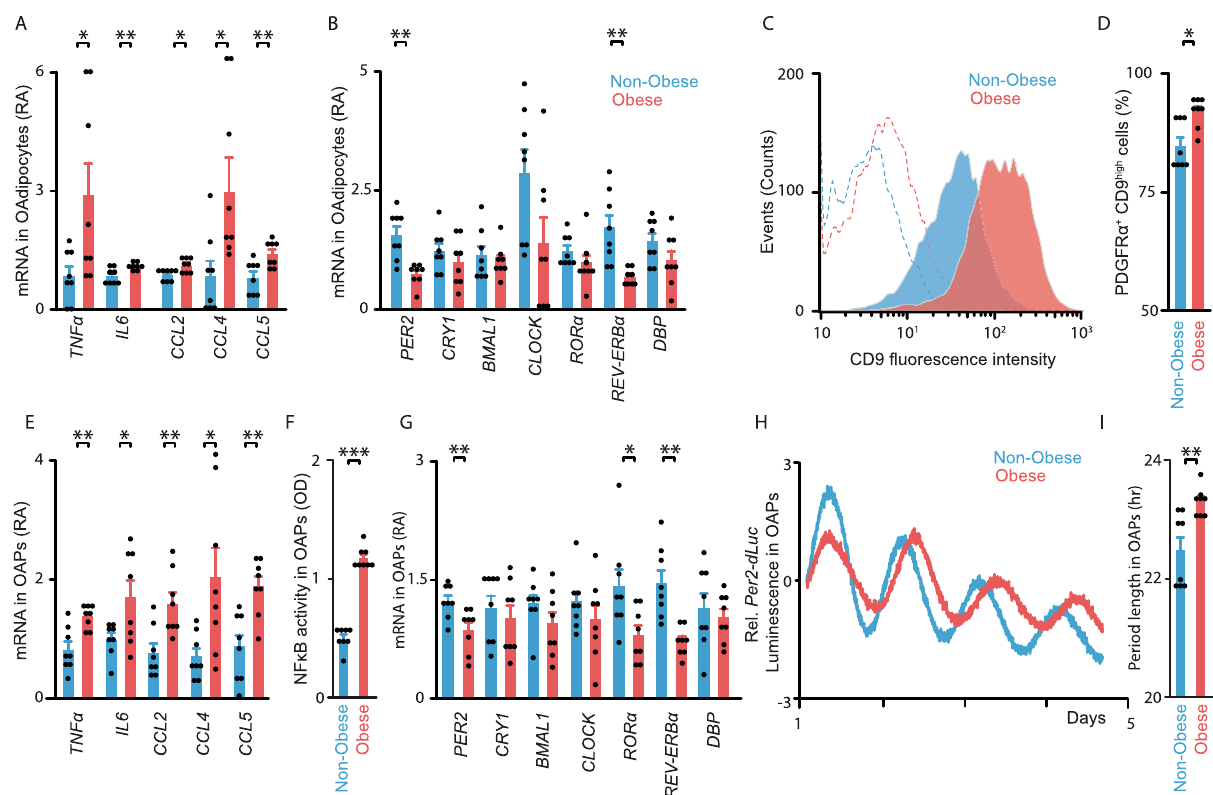
Fig. 1 Expression of pro-in fl ammatory factors and circadian clock function are altered in human omental adipocytes and precursor cells. A , B Expression of pro-in fl ammatory (cytokines and chemokines) ( A ) and core clock ( B ) genes in non-synchronized Omental Adipocytes (OAdipocytes) from non-obese (blue) or obese (red) patients. Values are displayed as mRNA Relative Abundance (RA). C , D Detection of the cell-surface glycoprotein CD9 in PDGFR α + CD34 + CD31 − CD45 − adipocyte precursors (OAPs) from non-obese (blue) and obese (red) patients by fl ow cytometry. Phycoerythrin fl uorescence (CD9) and Alexa Fluor red (CD140a) have been detected simultaneously, to determine the frequency of PDGFR α + CD9 high cells. C One representative trace (i.e., OAPs from one patient) per condition is shown. Dashed lines are the negative controls. D Percentage of CD9 high OAPs in non- obese vs. obese patients. E Expression of pro-in fl ammatory genes in non-obese or obese OAPs. F NF- κ B activity in non-obese or obese OAPs (phosphorylated p65, in Optical density, OD). G Expression of core-clock genes in non-obese or obese OAPs. H Normalized bioluminescence of Per2-dLuc reporter oscillations in synchronized OAPs obtained from non-obese (blue line) or obese (red line) patients. One representative trace per group is shown. I Period length of Per2-dLuc bioluminescence in hours (hr). All data are represented as mean ± SEM with n = 8 patients/ group. * p < 0.05, ** p < 0.01, *** p < 0.01, unpaired two-tailed t test. See also Supplementary Fig.